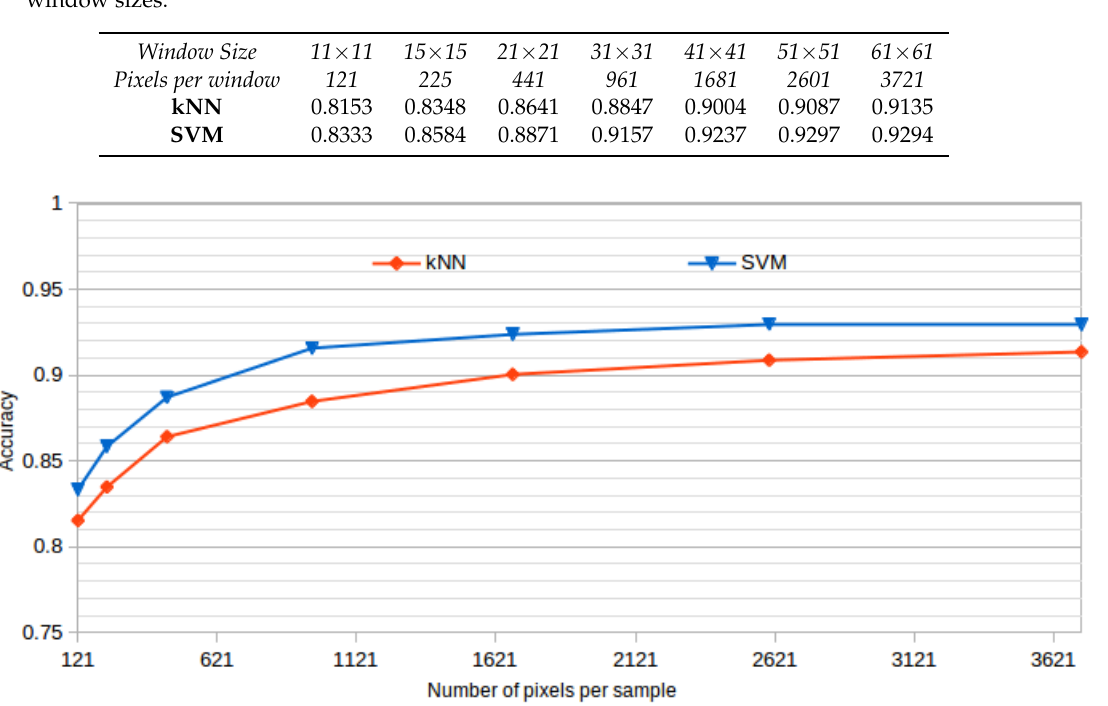
Table 2. Window size analysis. Best accuracy obtained by each tested classifier and progressive larger window sizes.